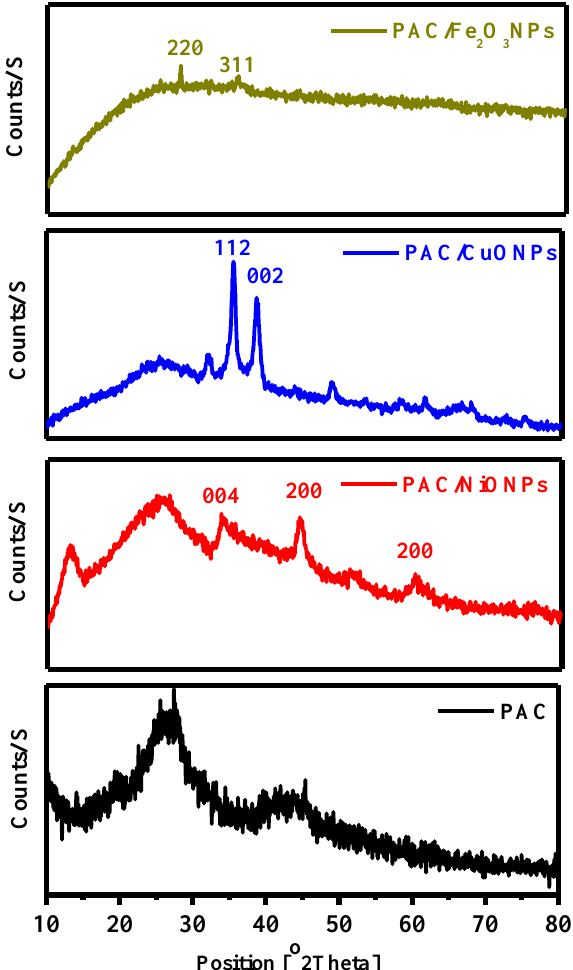
Figure 2. X-ray diffraction (XRD) pattern of PAC, PAC/NiONPs, PAC/CuONPs and PAC/Fe 3 O 4 NPs nanocomposites.